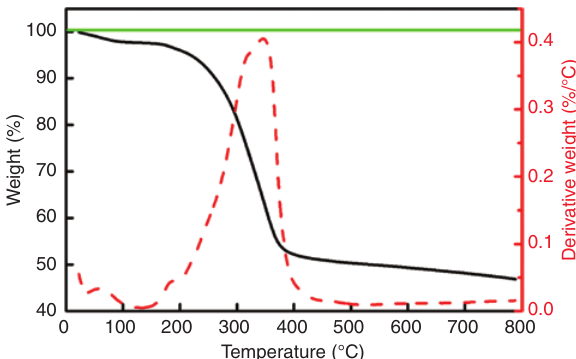
Figure 5: Thermogravimetric analysis (TGA) and differential thermal analysis (DTA) graph of bioreduced silver nanoparticles (AgNPs).